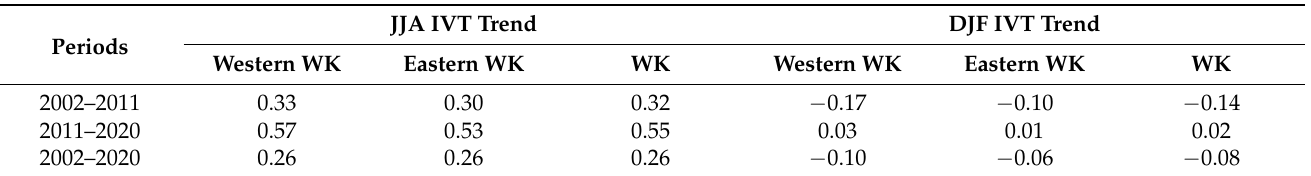
Table 8. JJA and DJF IVT trends (unit: kg m − 1 s − 1 a − 1 ) in western WK, eastern WK, and WK during three different